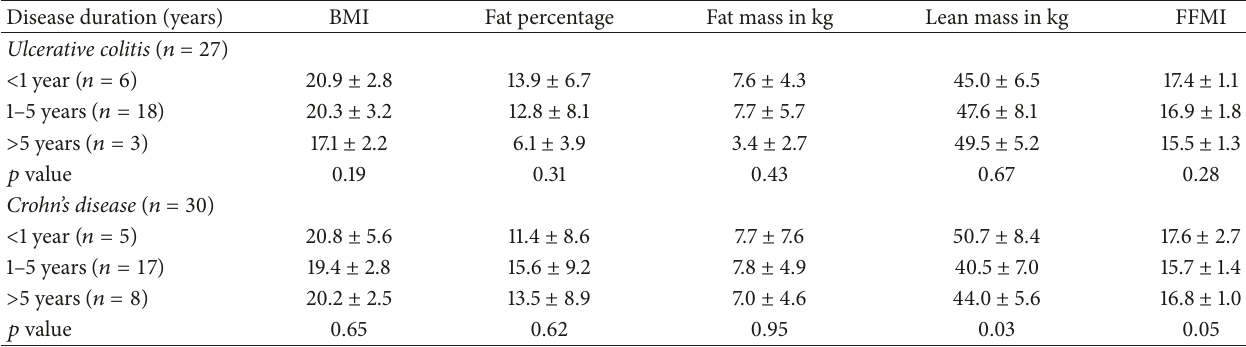
Table 6: Effect of disease duration on body composition in patients of ulcerative colitis (UC) and Crohn’s disease (CD) with active disease (excluding patients in